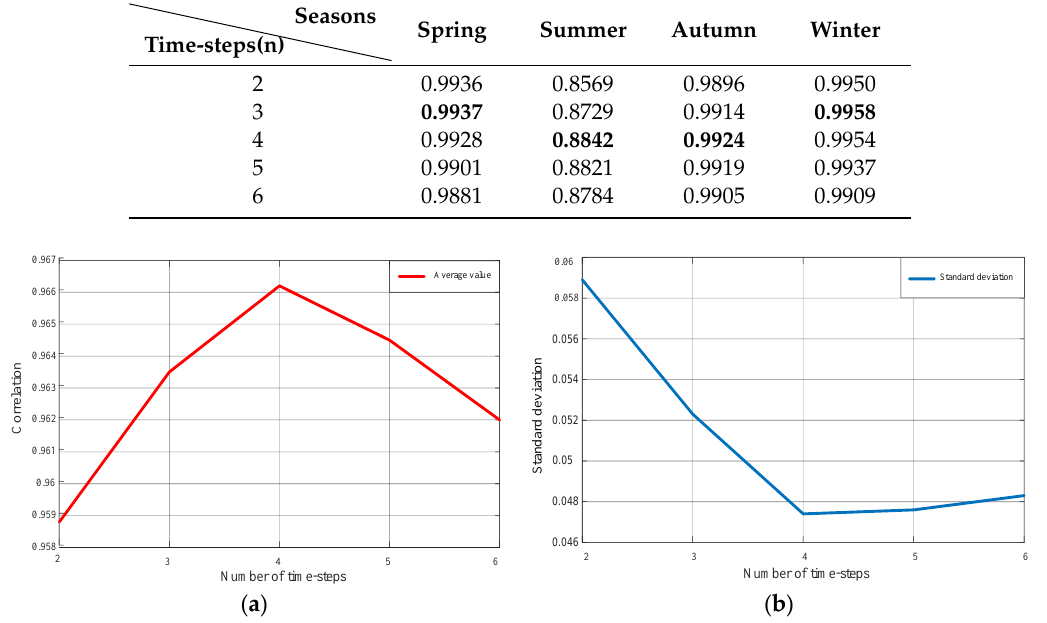
Table 2. The correlation between the d and p under di ff erent seasons and di ff erent time scales.